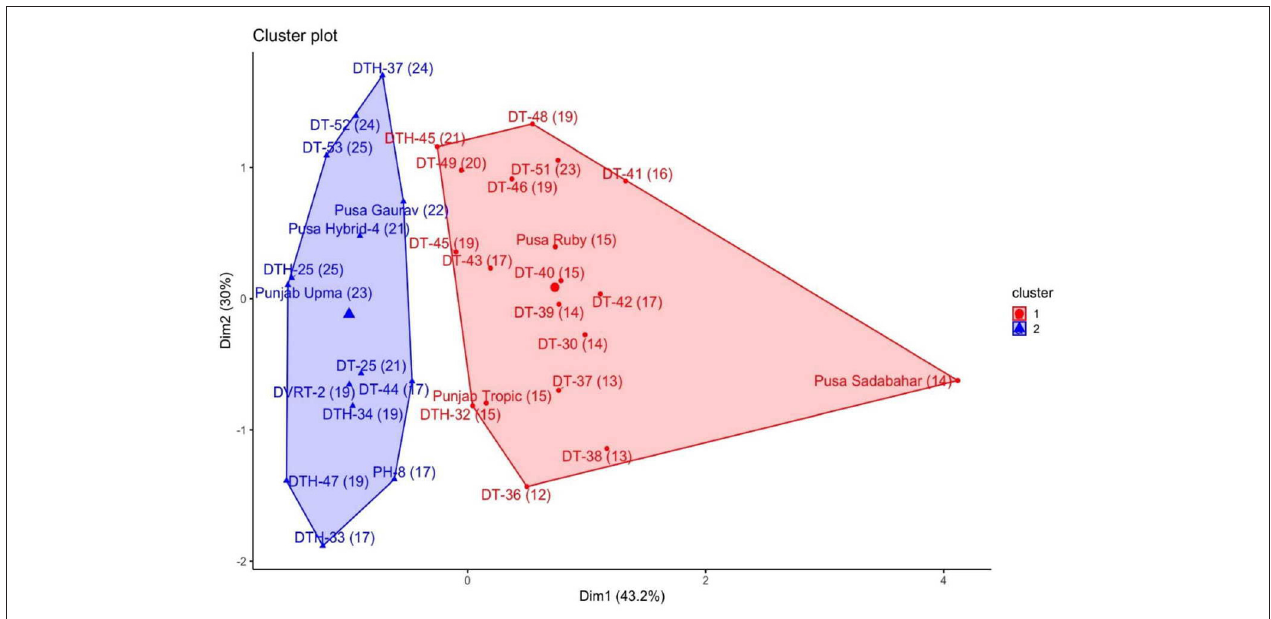
FIGURE 1 | Groups made by K-mean clustering method of all 33 lines. The blue cluster represents all high shelf life lines.